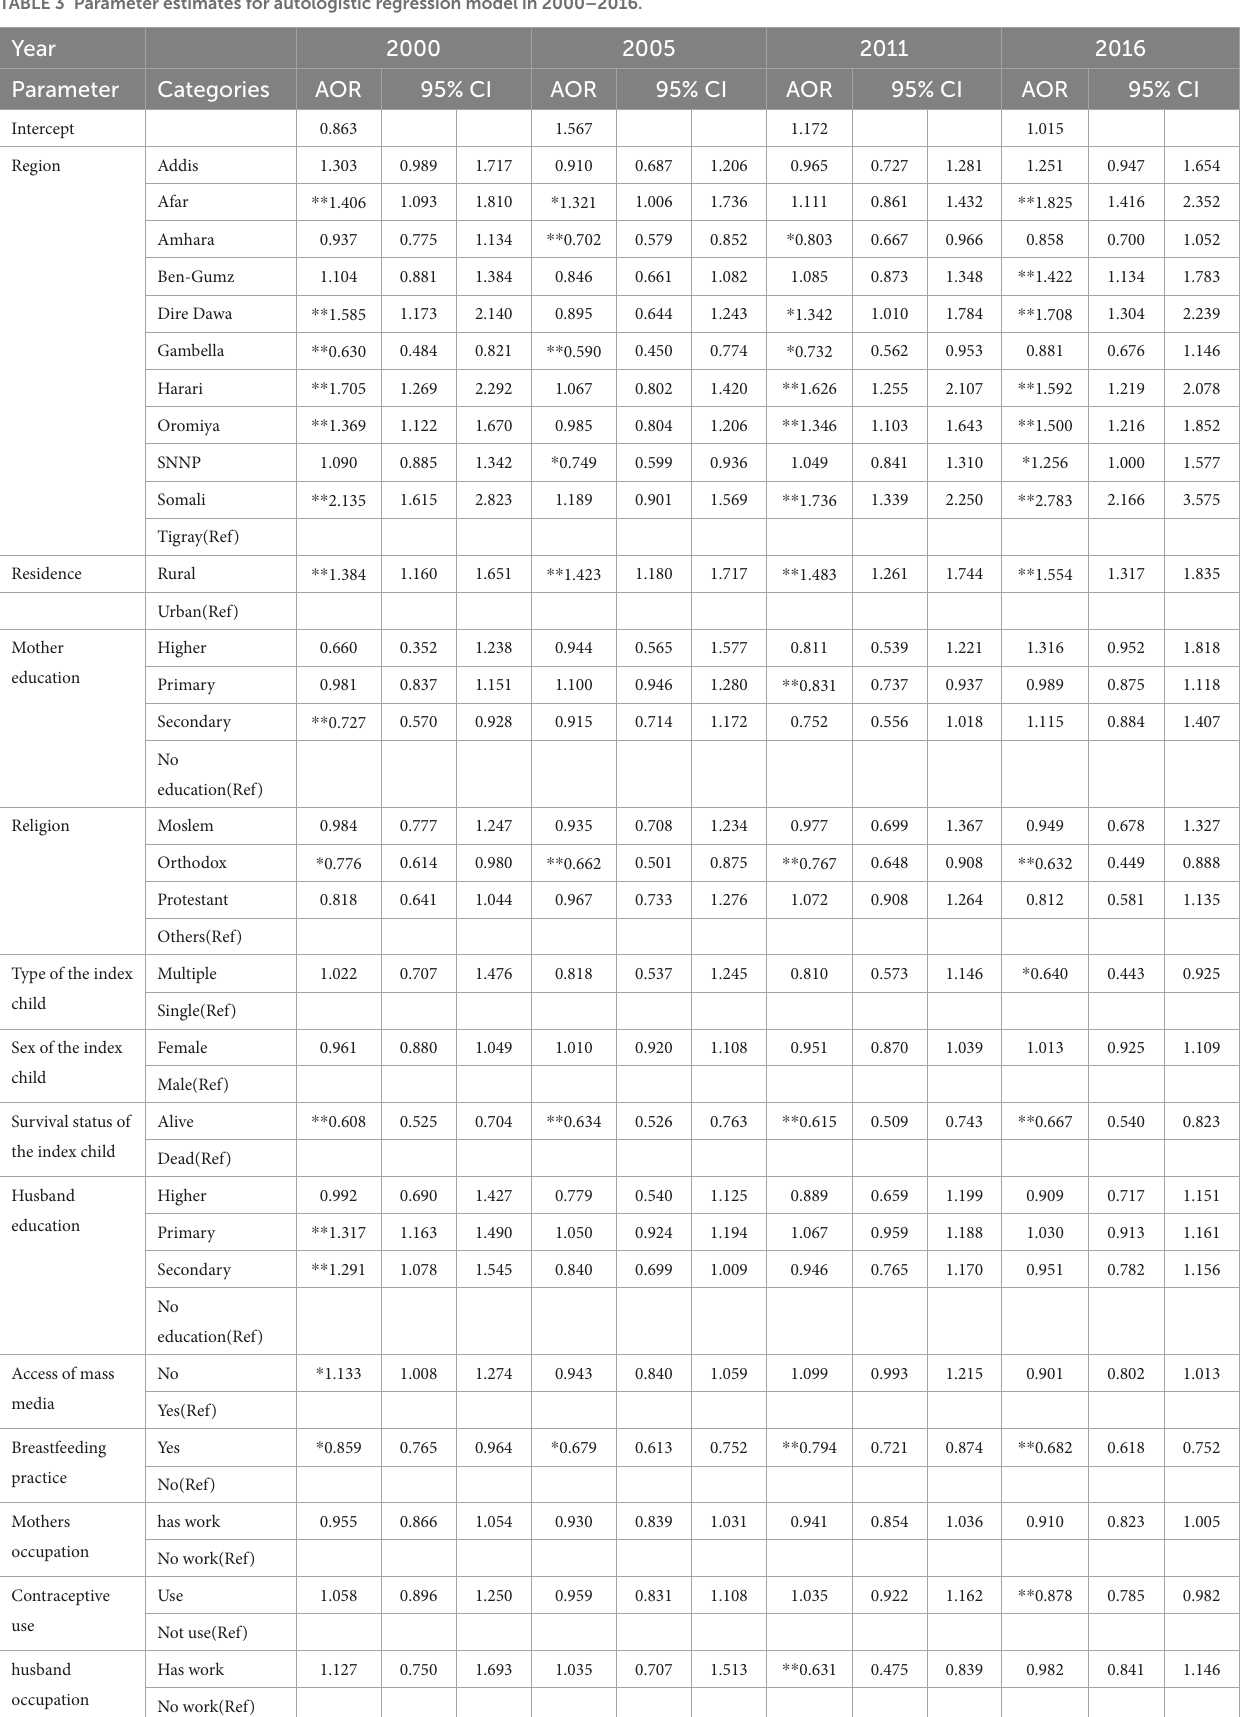
TABLE 3 Parameter estimates for autologistic regression model in